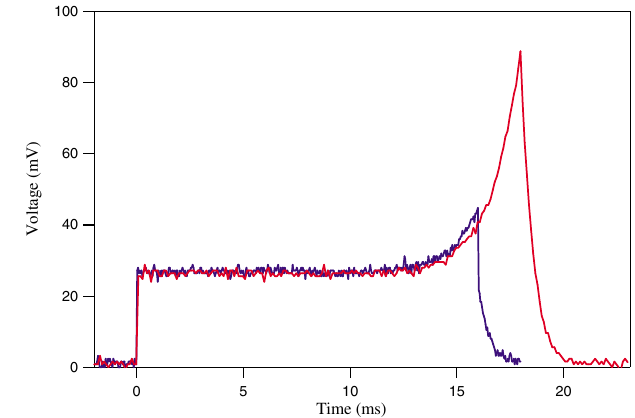
FIG. 3. (Color) FFT of a pure 2114.156 MHz signal (top) and FFT of the HOM voltage from the unstable cavity during beam breakup